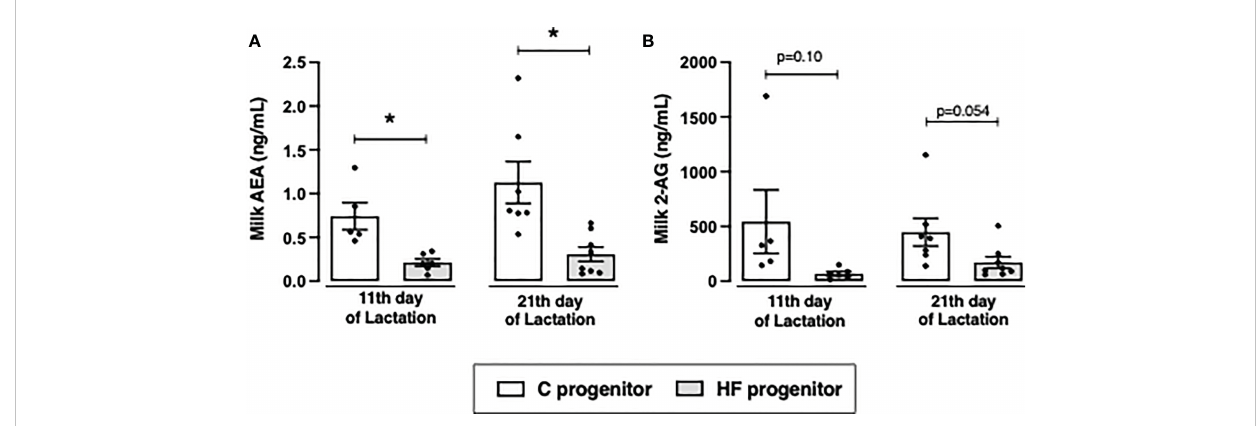
FIGURE 4 Effect of high-fat (HF) diet on the content of endocannabinoids in the milk of rat progenitors. (A) Milk anandamide (AEA) and (B) 2-arachidonoylglycerol (2-AG) in the postnatal days 11 and 21 of control (C) and HF progenitors. Data are presented as mean ± standard deviation and statistically signi fi cant differences were determined by unpaired Student ’ s t test. * p < 0.05